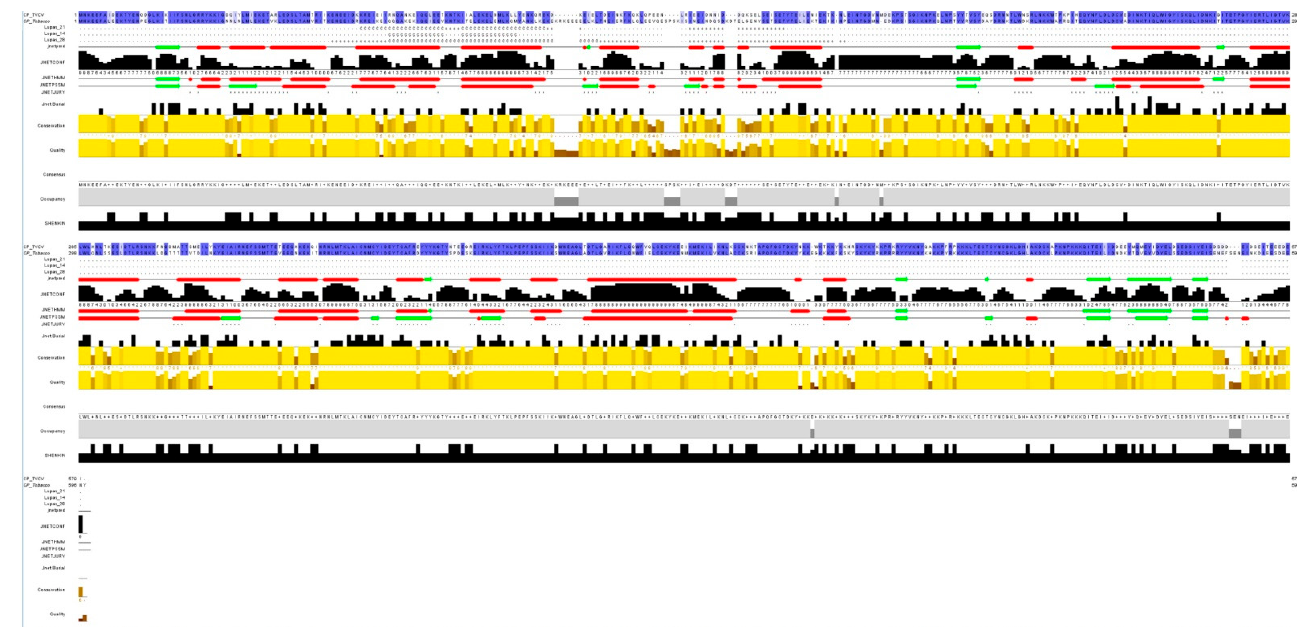
Figure 3. Jalview alignment of the CP encoded by Ntab-TN90_AYMY-SS16611 and TVCV. Conserved residues are indicated in blue in the Jalview alignment [121]. Conservation and quality of the alignment are indicated. Secondary structures, predicted by Jpred Secondary Structure Prediction are indicated in green ( β -sheets) and red ( α -helices); JNetCONF = the confidence estimate for the prediction; JNetHMM = HMM profile-based prediction; JNETPSSM = PSSM-based prediction; JNETJURY = a ‘*’ in this annotation indicates that the JNETJURY was invoked to rationalize significantly different primary predictions.